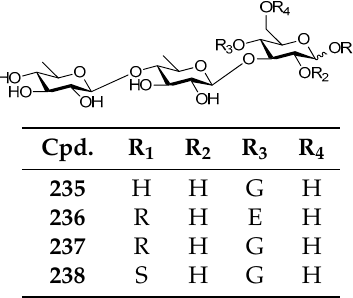
Figure 45. Structures of compounds 233 – 234.